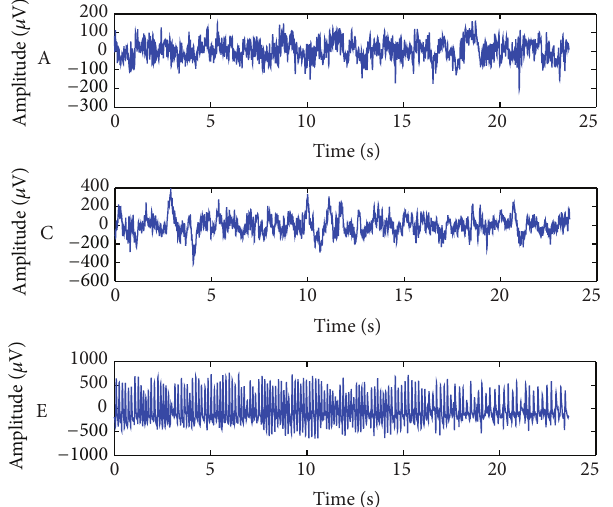
Figure 2: Example of three different classes of EEG signals taken from different